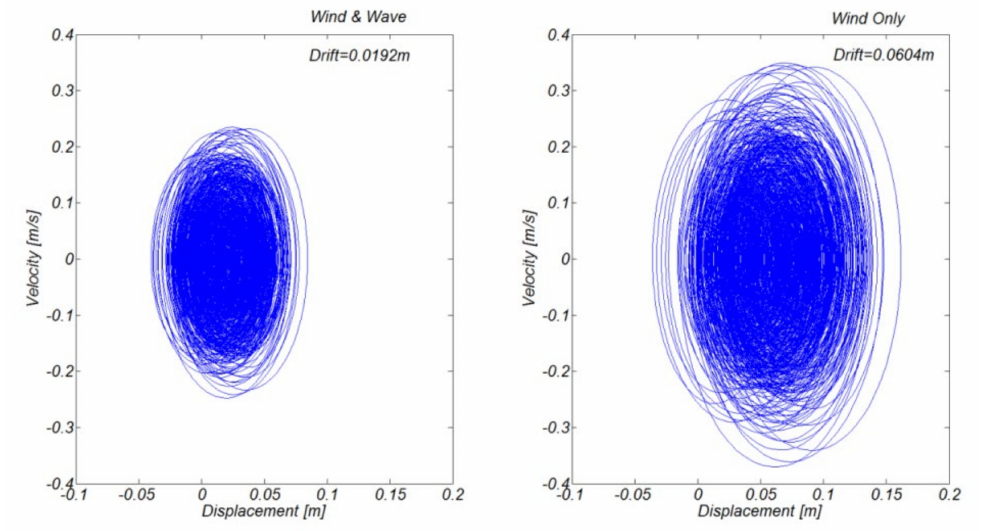
Figure 18. Trajectories of the o ff shore wind power